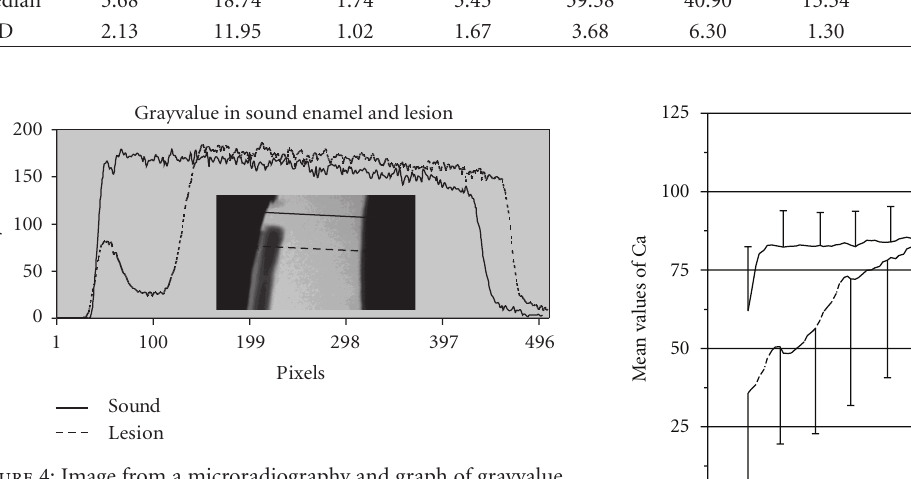
Figure 4: Image from a microradiography and graph of grayvalue. related to the image. Dotted line through the lesion and full line through the sound enamel.